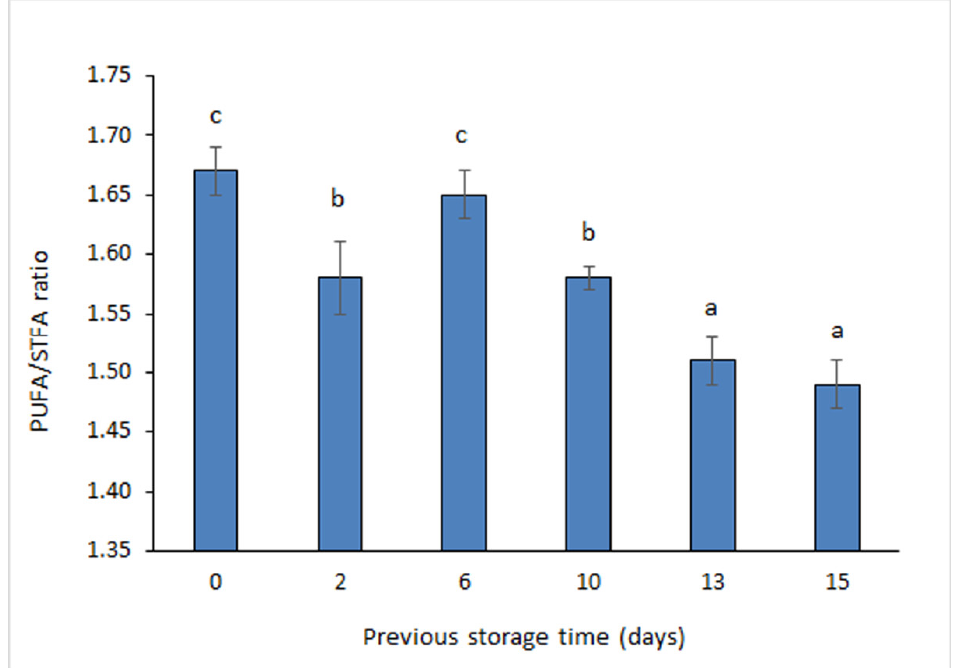
Figure 1. Determination of the polyunsaturated fatty acid/saturated fatty acid ratio in canned sardines subjected previously to storage on ice. Average values of three replicates ( n = 3). Standard deviations are indicated by bars. Average values accompanied by different letters (a–c) denote significant differences ( p < 0.05).